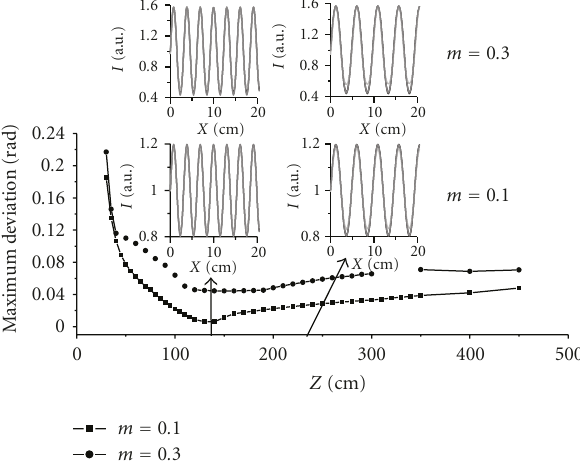
Figure 8: Maximum deviation of the di ff erence between the phase estimate and the real-phase value for reconstruction of the plane surface from four fringe patterns recorded at four wavelengths with a spherical wave illumination (paraxial approximation); the plots in the inset give the lateral profile of the fringes generated at λ = 790, 810, 850, and 910nm. Here, z is the distance between the grating and the plane.